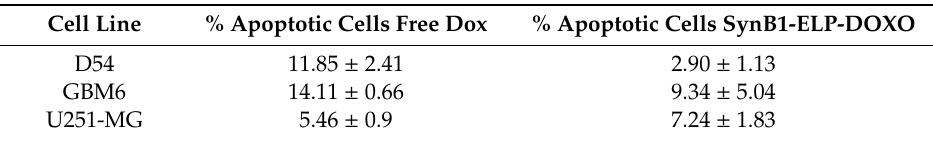
Table 2. Percentage of Apoptotic Cells. The percentage of Apoptotic Cells is shown as an average of three independent experiments. Summary of results were determined by analysis of 10,000 cells per sample, and results represent the mean +/ − SEM.